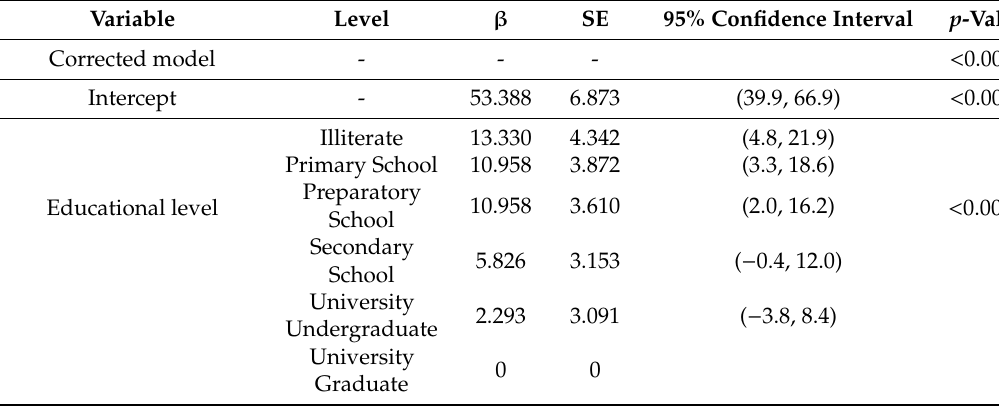
Table 5. Final general linear model with parameter estimates for knowledge